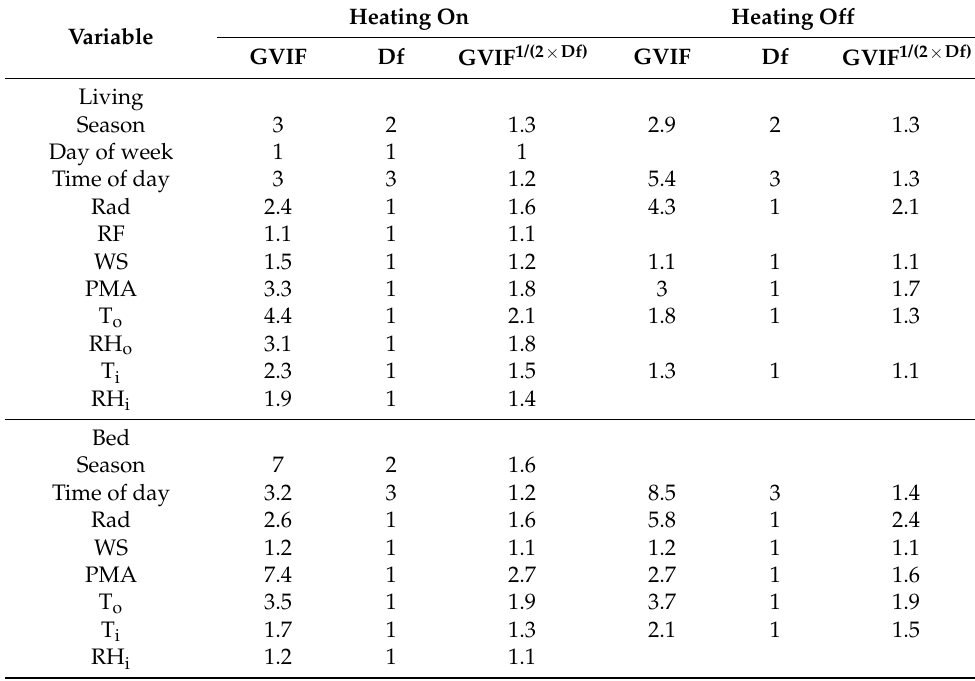
Table 5. GVIF analysis result from A/C Heating on and off